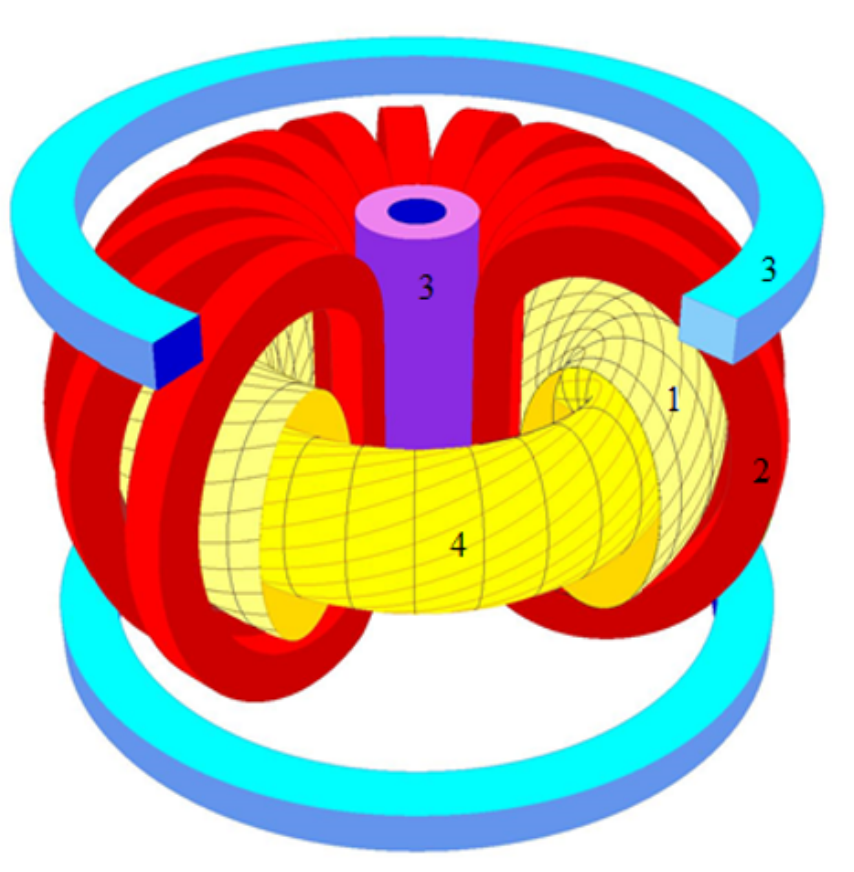
Figure 1. Vertically elongated tokamak without iron core: 1 is the VV; 2 is the toroidal field coil; 3 are the poloidal field inner and outer coils; 4 are plasma and helical magnetic lines (©ITER Project Center (Russia): https://www.iterrf.ru/index.php/istoriya-sozdaniya-proekta, accessed on 21 December